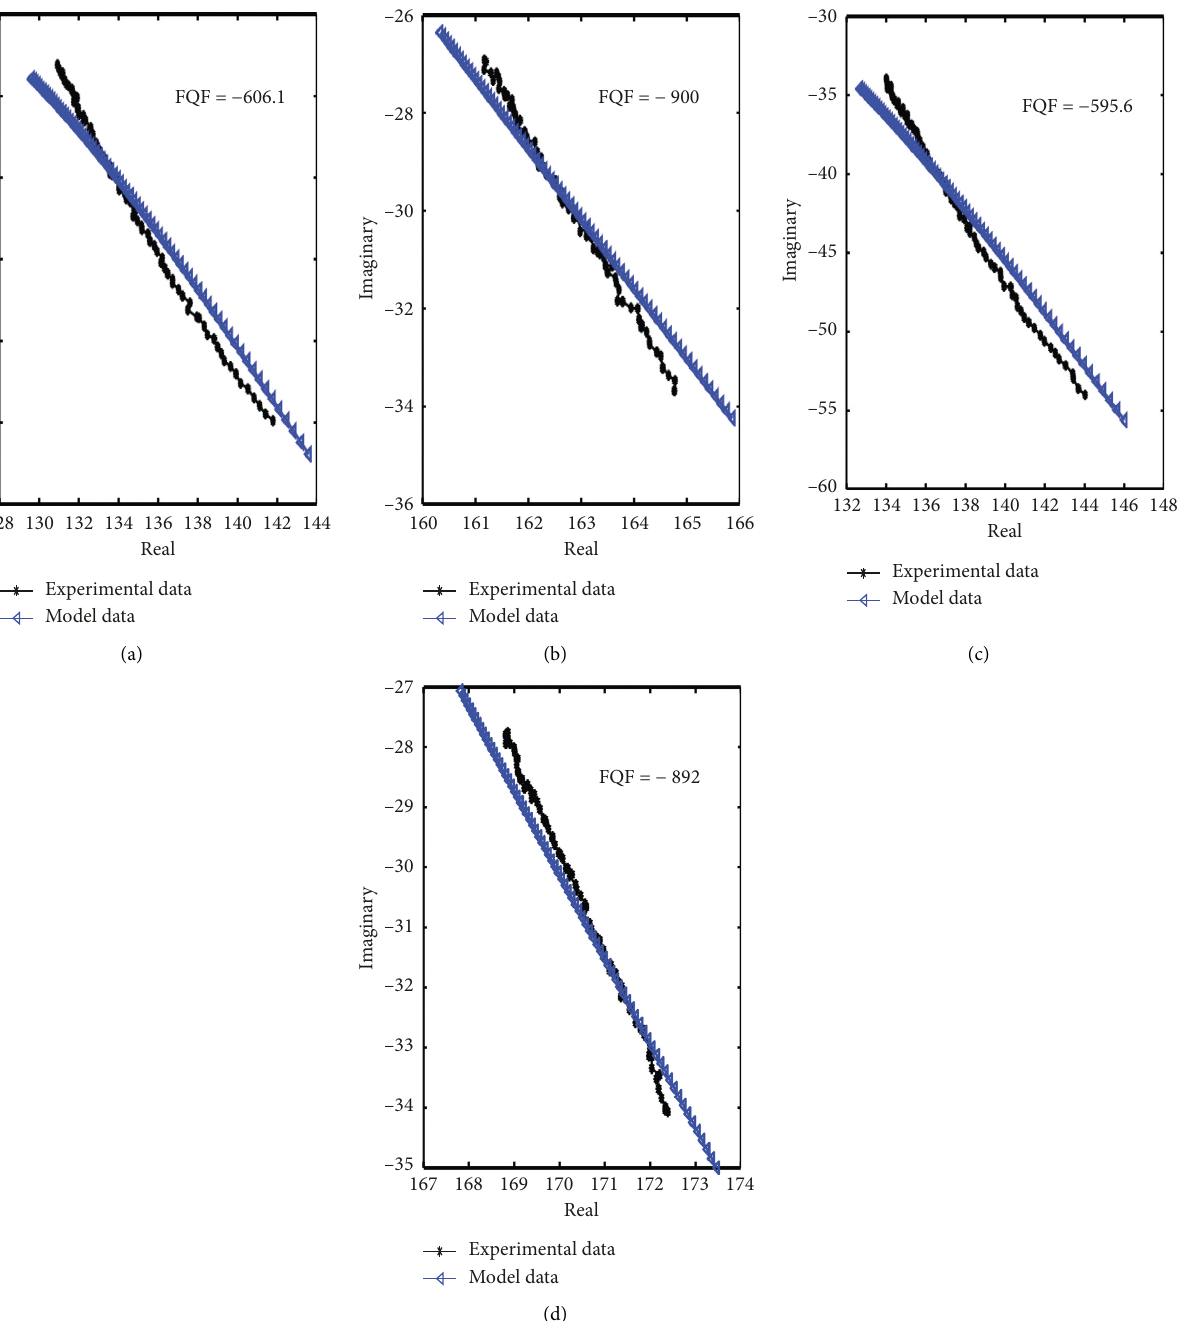
Figure 3: Impedance spectrum of the FOE13 and FOE8 sensors in urea adulterated milk. FOE13 sensor is for frequency range 5 kHz to 12kHz and FOE8 sensor for frequency range 13kHz to 20kHz. (a) FOE13 in 1.0 mg/ml urea adulteration; (b) FOE8 in 1.0mg/ml urea adulteration; (c) FOE13 in 1.4mg/ml urea adulteration; (d) FOE13 in 1.4mg/ml urea